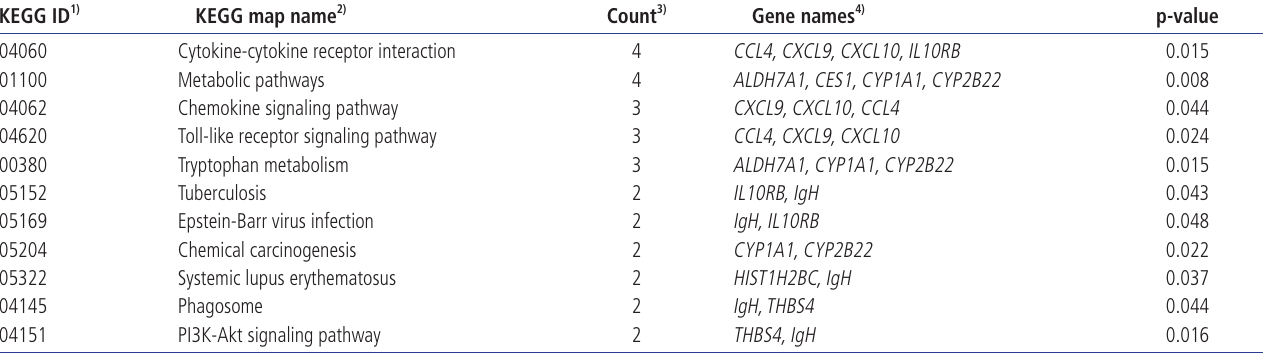
Table 3. Various KEGG pathways observed in the kidney samples of DON- and ZEN-contaminated dietary treatment groups of piglets KEGG ID